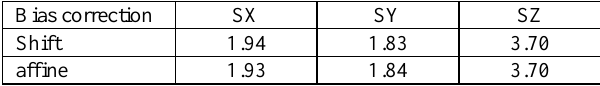
Table 2: Accuracy of Ziyuan-3 3-D-orientation at 12 GCPs The result based on a three-dimensional orientation does not